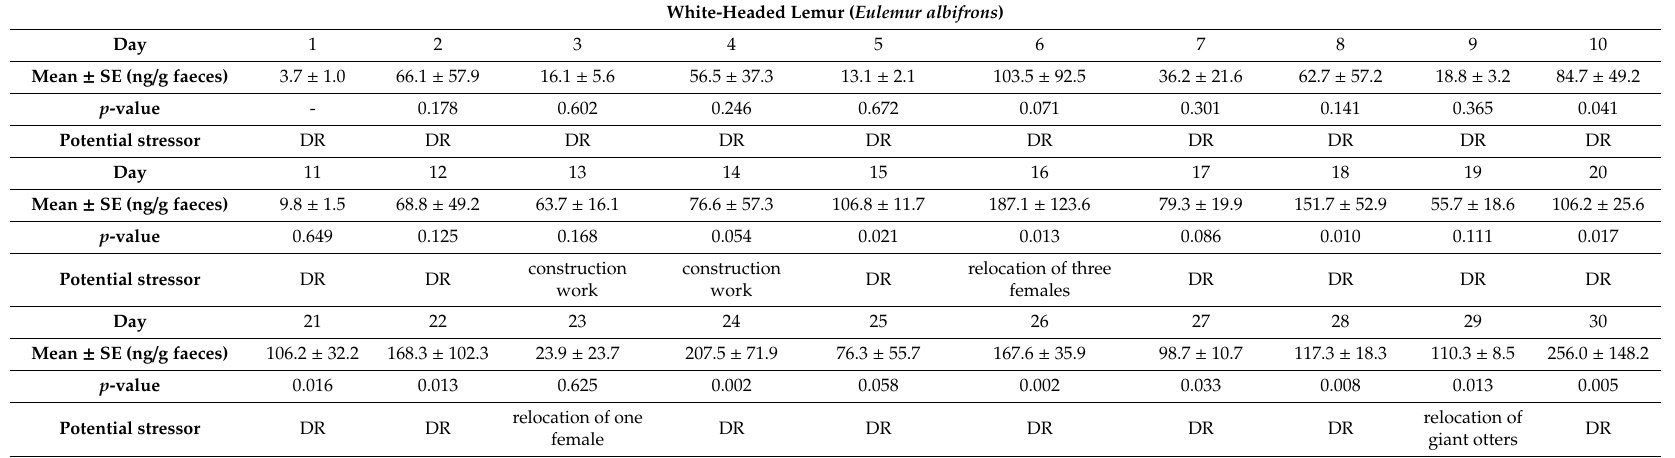
Table 3. Mean concentrations of the faecal glucocorticoid metabolites (FGMs) in white-headed lemurs and potentially stressful events for each day of monitoring. White-Headed Lemur ( Eulemur albifrons